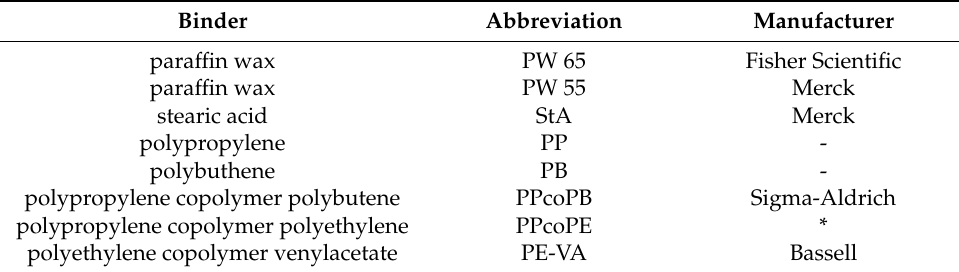
Table 1. Used binder components for MIM of Mg. Binder Abbreviation Manufacturer paraffin